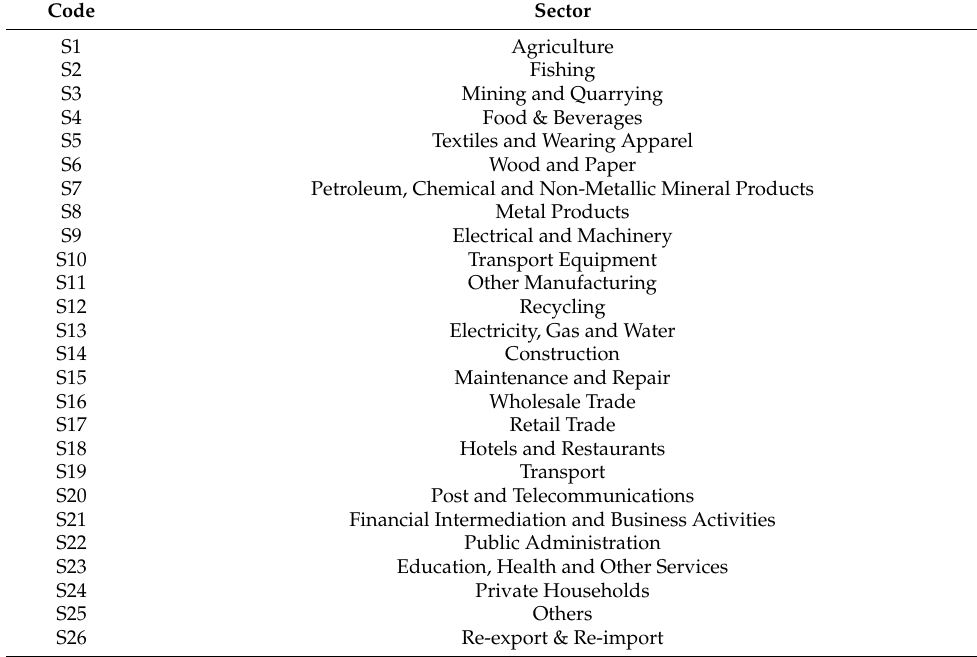
Table A1. Sectors and their corresponding